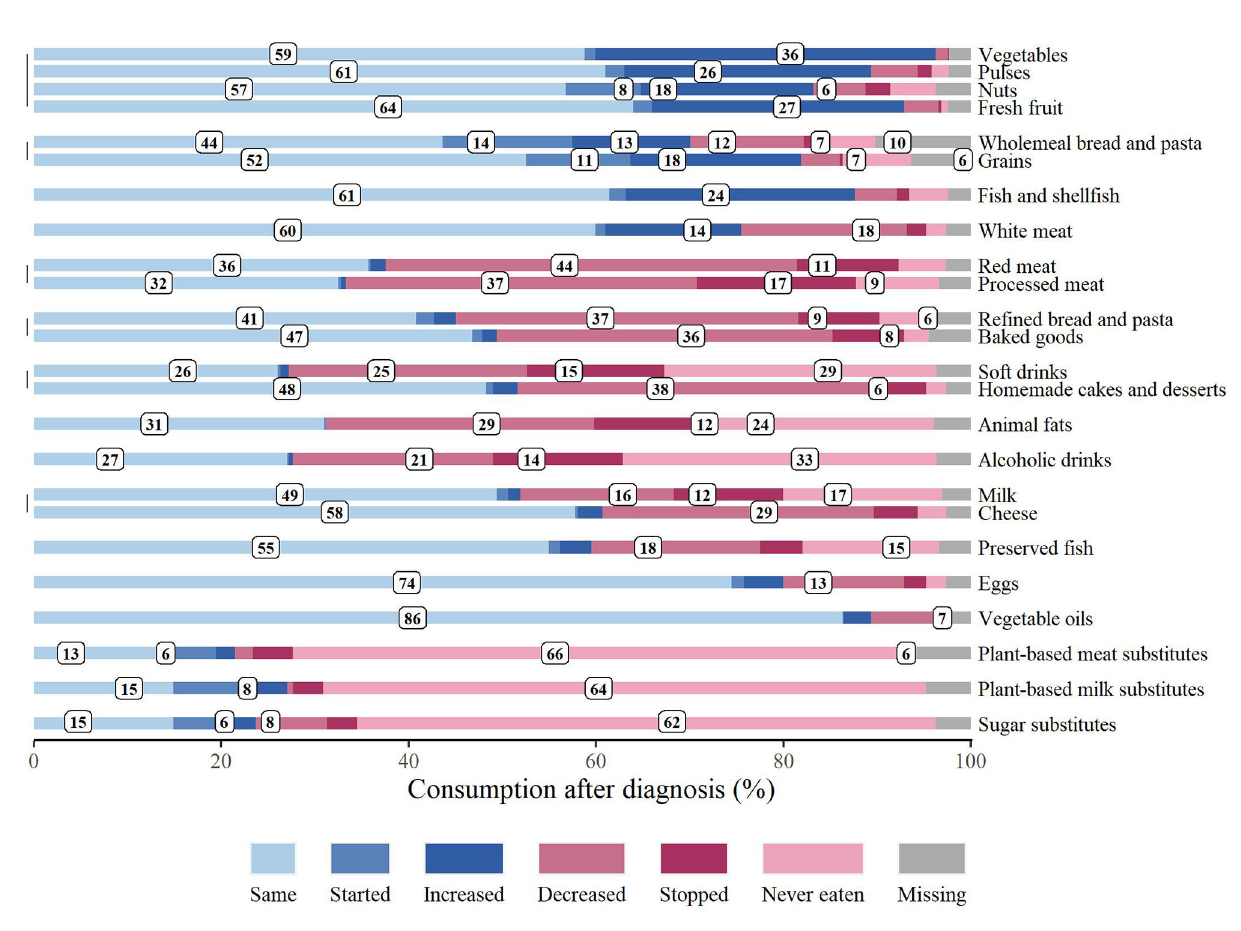
FIGURE 1 | Changes in food consumption after breast cancer diagnosis. Food consumption patterns, reported by respondents, are expressed in percentage. “ Missing ” indicates that no responses were